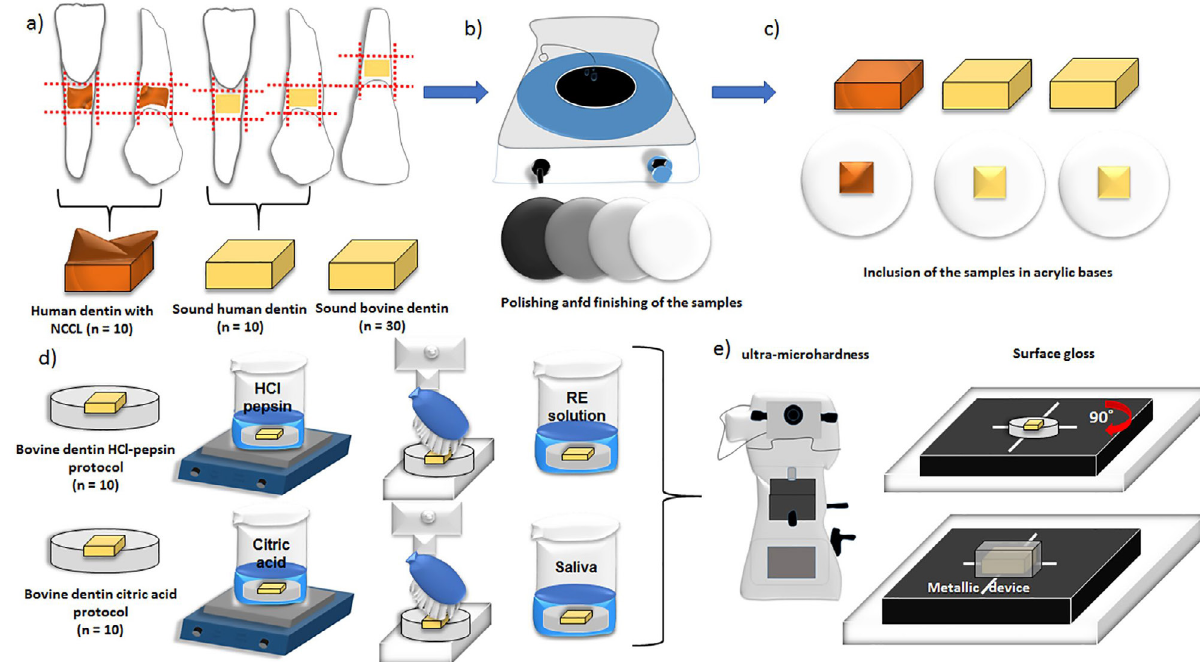
Figure 1- (a) Blocks of root dentin; n=10 human dentin with NCCL (incisors and premolars); n=10 sound human dentin (incisors and premolars); n=30 sound bovine dentin (4x4 mm); b) Polishing of samples in automatic polishing machine with # 600, # 800, # 1200 and 1-μm diamond polishing suspension; c) Inclusion of all samples in acrylic resin bases; d) Twenty bovine dentin blocks were subjected to either of two erosion protocols. HCl-pepsin protocol (n=10) and citric acid protocol (n=10); e) Analysis of the mechanical properties (MH and Eit*) and surface gloss of all samples. NCCL=non-carious cervical